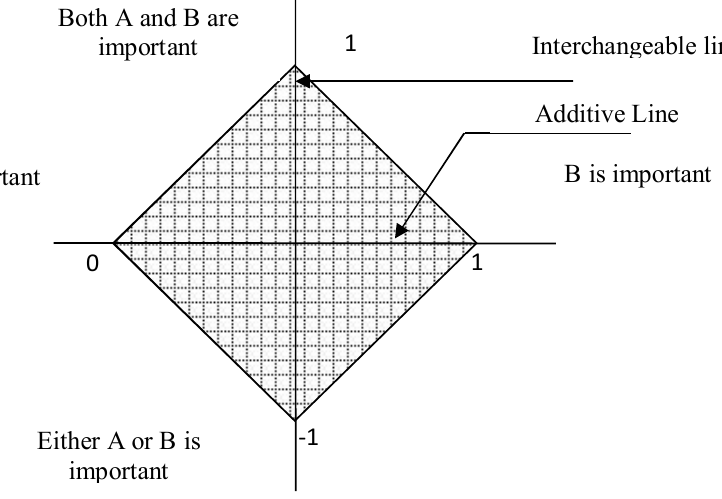
Fig. 5. Diamond pair wise comparison’s properties (Takahagi,